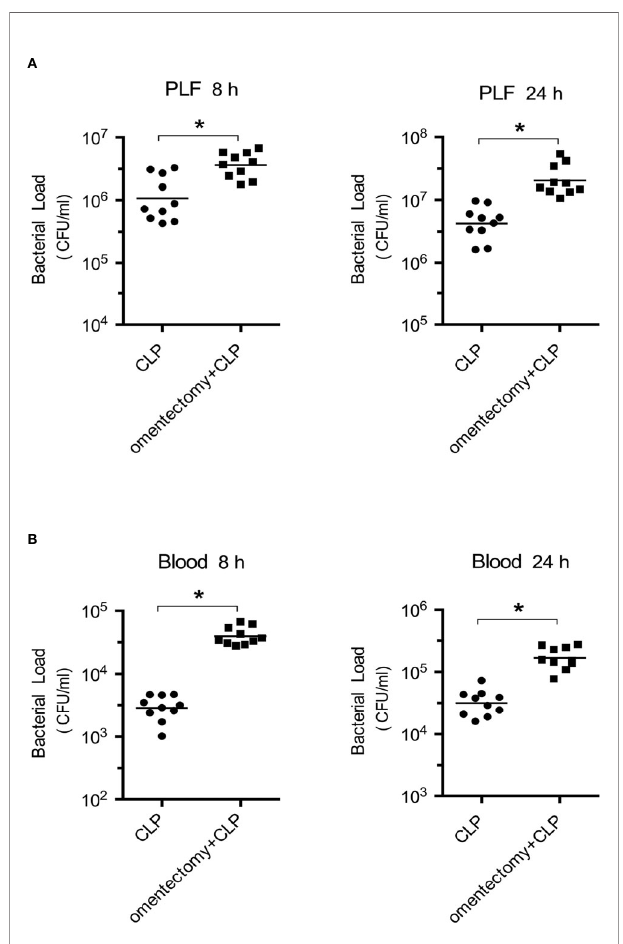
FIGURE 2 | Impaired bacterial clearance in omentectomized mice. At 8 and 24 h after CLP, PLF (A) , and peripheral blood (B) were collected (n = 9~10 per group). After dilution, 100 m l of each sample was placed on TSA-blood plates, and bacterial CFUs were determined. The horizontal bar represents the mean for each group. Symbols represent individual mice. * p < 0.05 for omentectomized vs